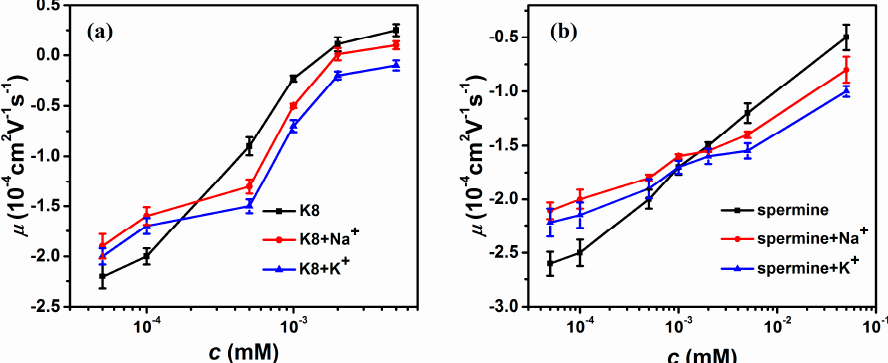
Figure 2. Electrophoretic mobility μ of condensed DNA as a function of the multivalent ions in a buffer containing monovalent ions (3 mM Na + , 3 mM K + ). ( a ) The data for K8, K8-Na + solution and K8-K + solution (black, red, blue). ( b ) The data for spermine, spermine-Na + solution and spermine-K + solution (black, red, blue). Each data point is the average of three consecutive measurements with the corresponding standard deviation as the error.